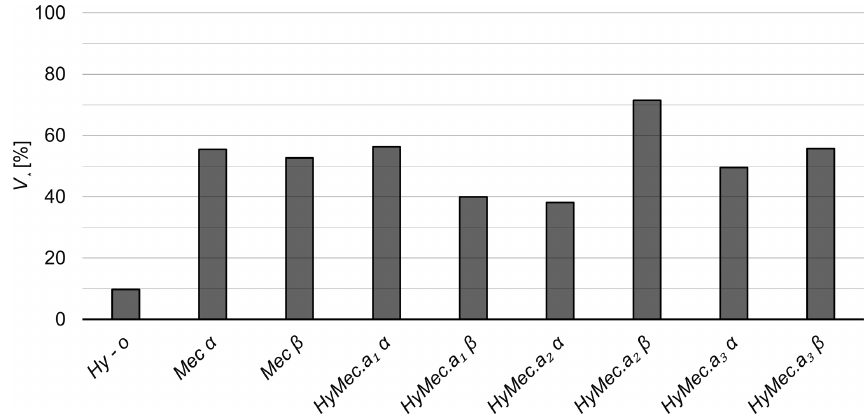
Figure 9. The ratio V ∗ (in %) of the deposit volume V dep and the supply volume V (cid:54) after the repetitive hydrograph tests α and β for the cases of the non-overflowed flow constriction (Hy-no), overflowed bar screen (Mec) and the combination of overflowed bar screen superposed to the flow constriction (HyMec), with varying opening heights a 1 , 2 , 3